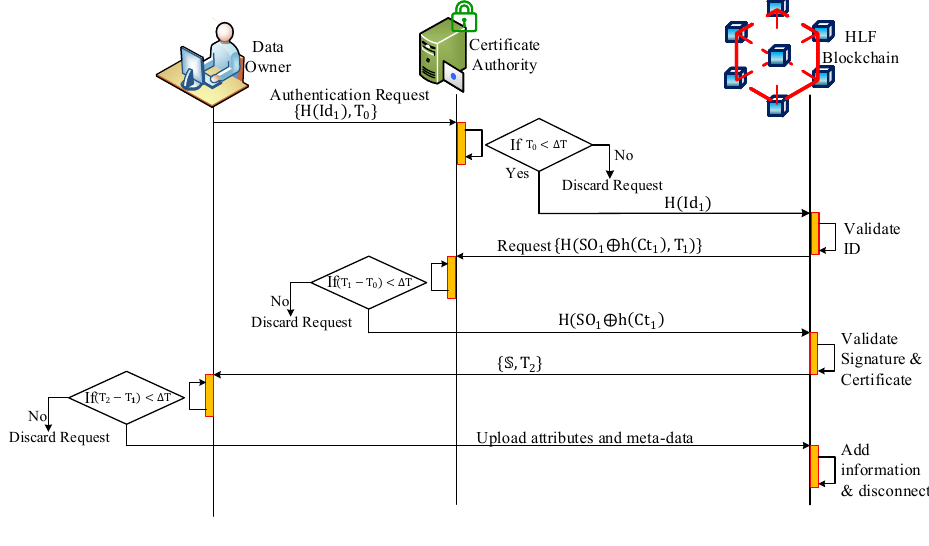
Figure 5. Workflow of DO